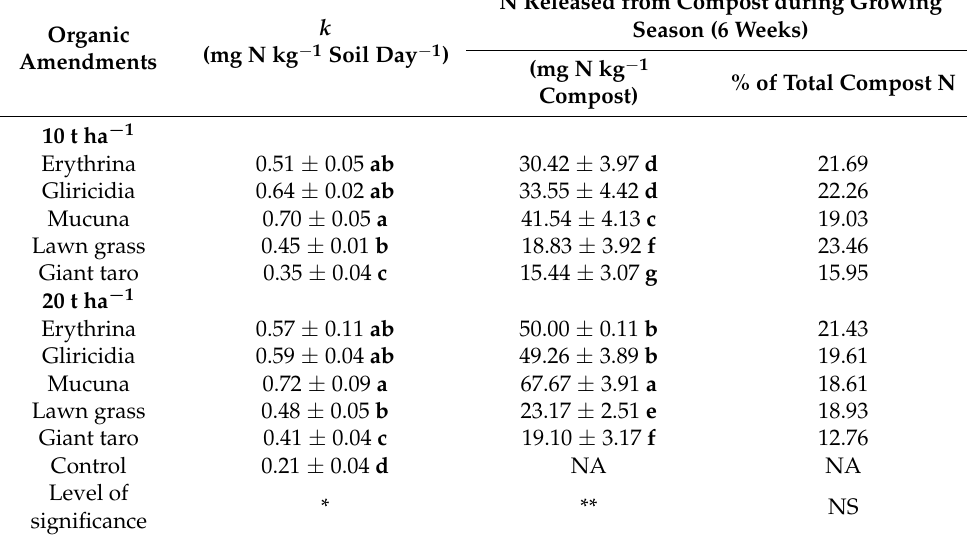
Table 3. Interaction effects of organic amendments with two application rates (10 and 20 t ha − 1 ) on N mineralization rate ( k ) (mg N kg − 1 soil day − 1 ) (28 ◦ C), net N mineralization and % of total N released